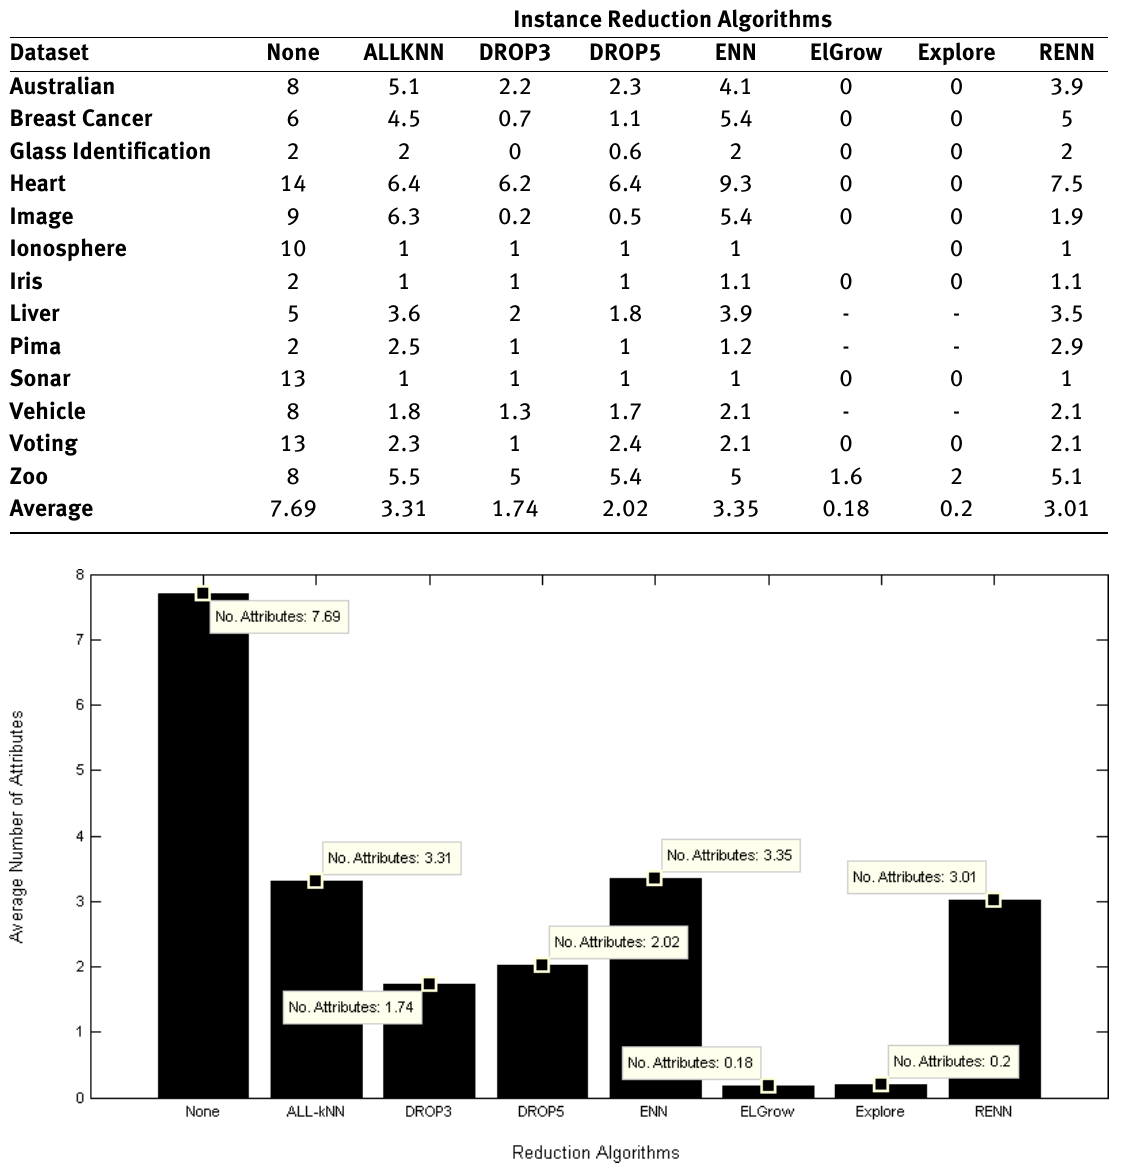
Figure 4: Average Number of Attributes for Unpruned Trees With 0% Noise Ratio